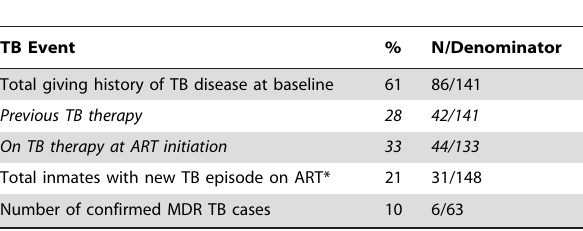
Table 2. TB rates pre-ART, at ART initiation and on